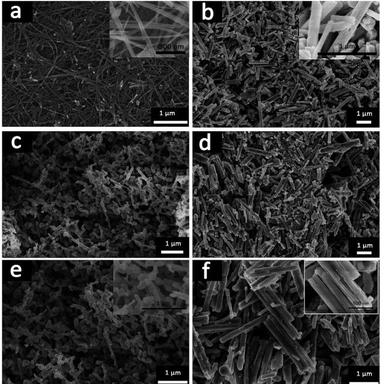
SEM images of (a) MnO2 nanowires, (b) MnO2 nanorods templates, and as-synthesized Li1.2Ni0.15Co0.1Mn0.55O2 (c, e) CLNs, (d, f) AMs (insets are the corresponding magnified SEM images).